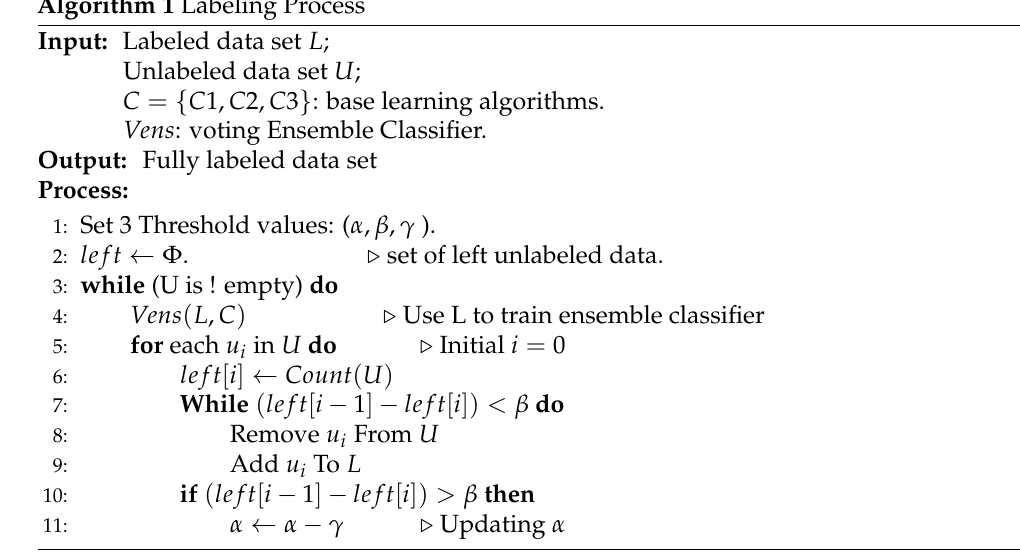
Algorithm 1 Labeling Process